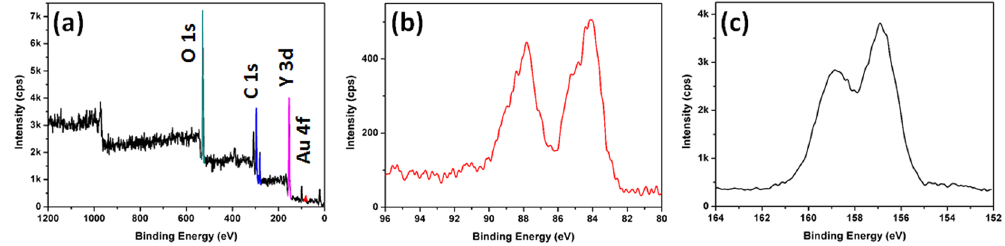
Figure 4. XPS spectrum. Typical XPS spectrum ( a ), Au 4f 7/2 ( b ) and Y 3d ( c ) of hybrid dual-layer film.